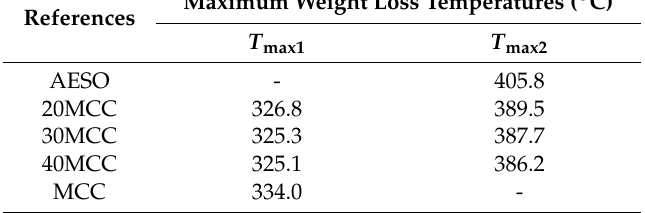
Table 2. Maximum weight loss temperatures of pure MCC, AESO, and MCC/AESO composites with different MCC loadings.